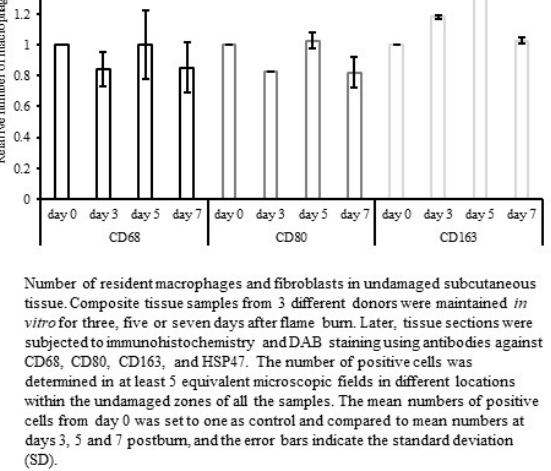
Figure A2. Number of macrophages in unharmed zones.